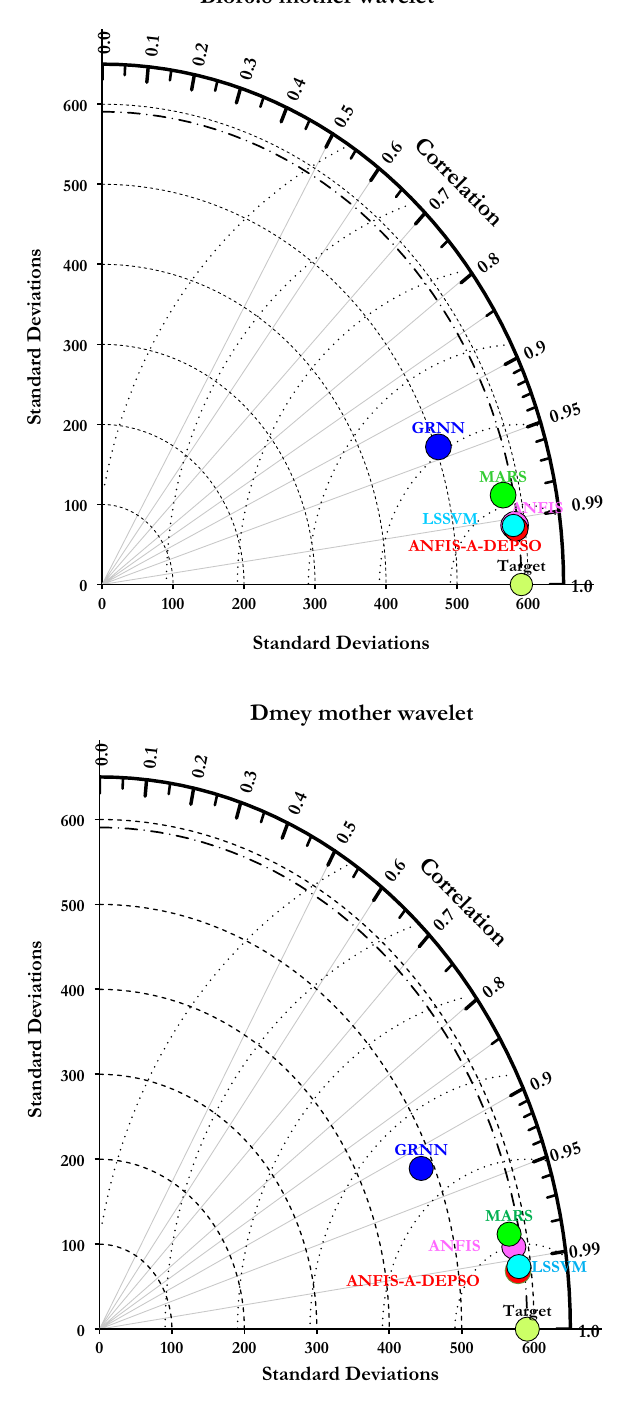
Figure 14. Taylor diagram of all ML models for Bior6.8 (upper panel) and Dmey (lower